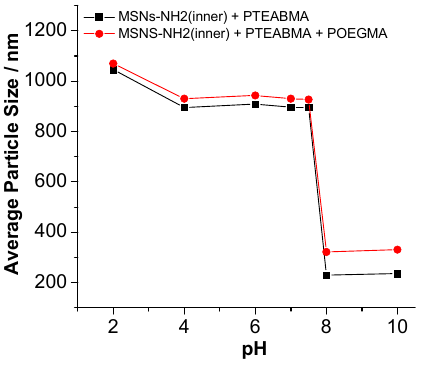
Figure 5. Average hydrodynamic diameters of PTBAEMA-MSNs and PTBAEMA-b-PEGMEMA-MSNs at different pH values, as measured by dynamic light scattering.